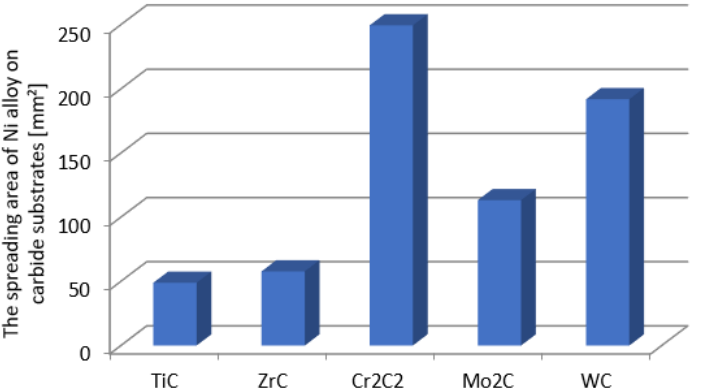
Figure 4. The surface areas of the NiBSi alloy droplets spread over the surface of particular carbides after the end of the entire wettability test (average of two trials).